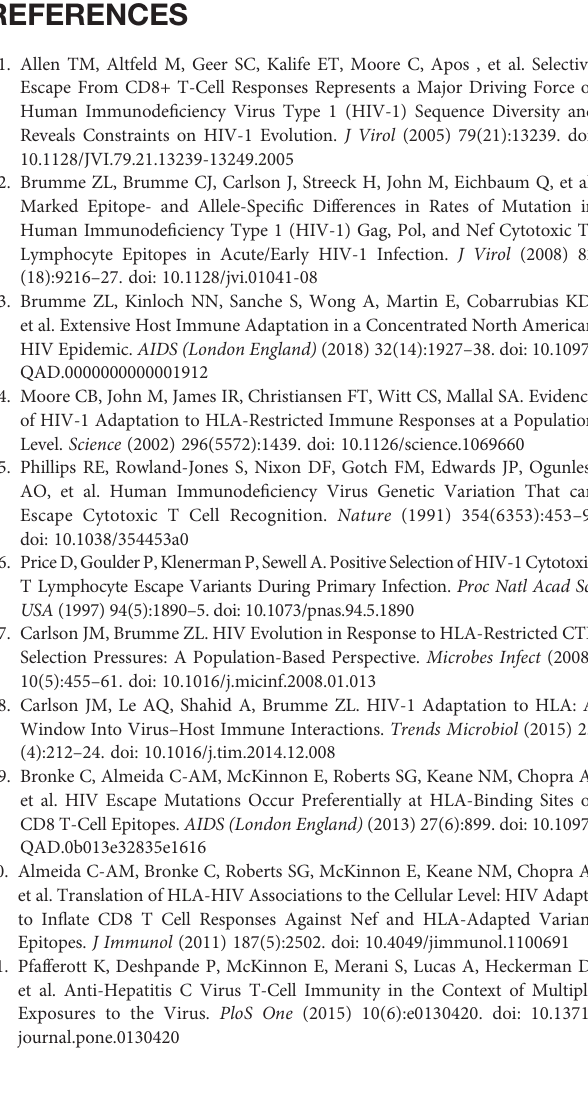
Supplementary Figure 2 | No differences in TCR CDR3 clonality between NAE- and AE-activated CD8 + T cell populations. (A) There was no difference in clonality scoresforTCRsidenti fi edafter stimulationwitheithertheNAEor AEpeptidefor TL10, RF10 and KY11 (N = 7; p=0.20; paired t-test). (B) There was no difference in the clonalityof resting cross-reactive(dualtetramer + ) Tcellsofchroniccomparedto acute HIV-1 infected subjects for TL10, RF10 and TY8 (N = 7; p=0.13; unpaired t-test). Supplementary Figure 3 | T cell memory subtype composition of tetramer + and activated antigen-speci fi c T cells based on CCR7 and CD45RO expression. (A) Four T cell subtypes were distinguished using CCR7 and CD45RO expression by fl ow cytometric analysis of index-sorted cells. (B) T cells were predominantly of a speci fi c memory phenotype across all conditions for a subject with Tem being the most predominant across all cells sorted. Note, Teff could not be differentiated into Tem and Temra subtypes based on the markers used. Here, only TL10-speci fi c CD8 + T cells from subjects C1 and C2 are shown. Supplementary Figure4 | CharacterizationofrestingandactivatedmemoryCD8 + T cellscross-reactivetoNAEandAEformsofTL10. (A) Boxplotsdepicttheexpressionof marker genes that identi fi es immune functionality (pro-in fl ammation, activation and exhaustion markers) and sex (N = 3). * p<0.05 and ^ p<0.05 Kruskal – Wallis test on rested and activated memory T cells, respectively. Note TNFRSF9 encodes the protein CD137. (B) Flow cytometric visualization of PD-1 surface expression (N = 3).